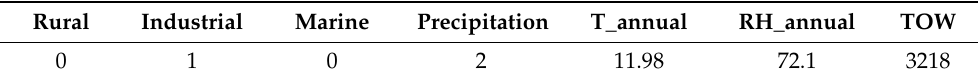
Table 4. Example of model input data.